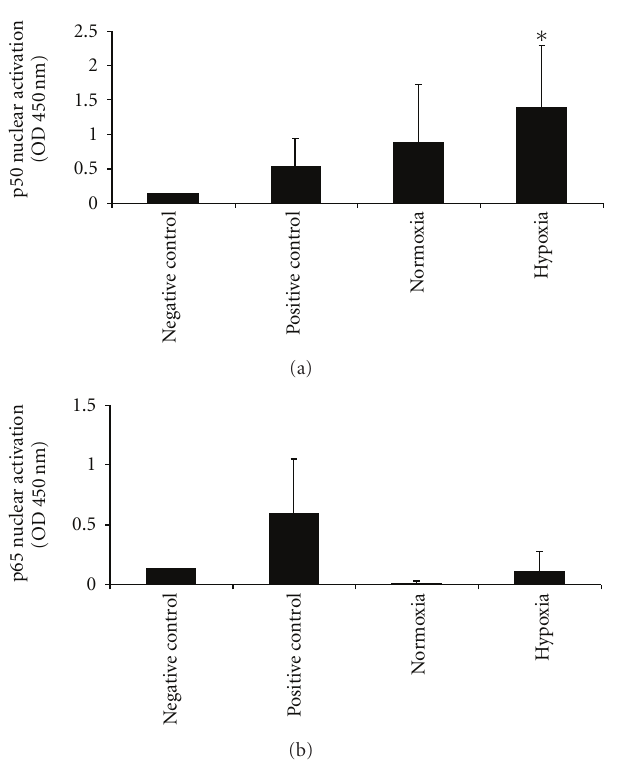
Figure 6: (a) Nuclear p50 activation in PBMC under normoxia and after hypoxia. (b) Nuclear p65 activation PBMC under normoxia and after hypoxia. n = 14; data are expressed as mean ± SD.